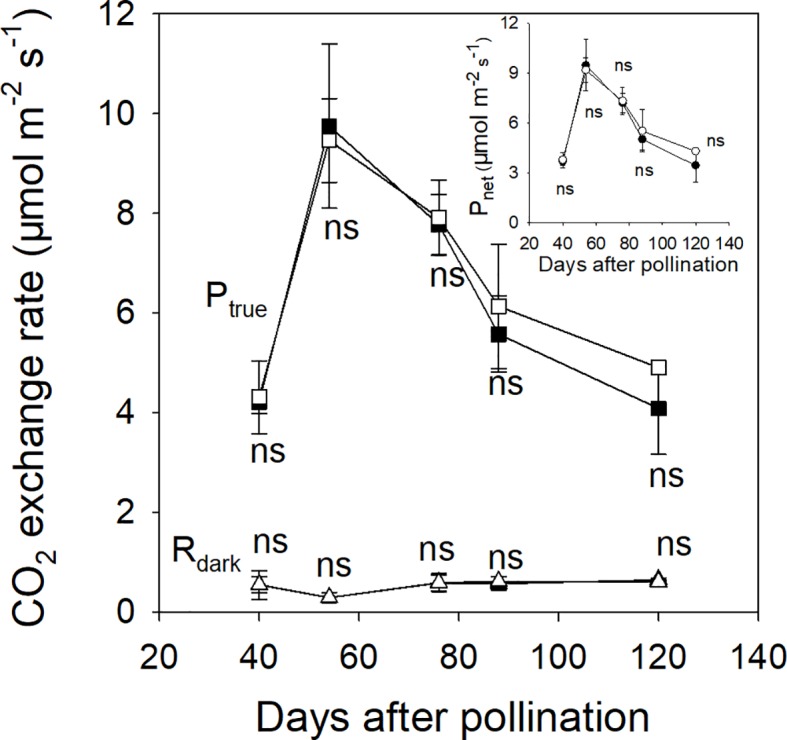
The true photosynthetic rate (Ptrue, squares), the dark respiration rate (Rdark, triangles) and the net photosynthetic rate (Pnet, circles in insert) of intraspecific hickory (Carya cathayensis) leaves associated to fruits developed either after intraspecific hickory pollination (ph fruits, closed symbols), or after interspecific pollination by pecan (pp fruits, open symbols), at the different fruit growth stages in 2015. Significance of the differences between the leaves associated to ph and pp fruits: ns, P > 0.05. n = 4 trees.